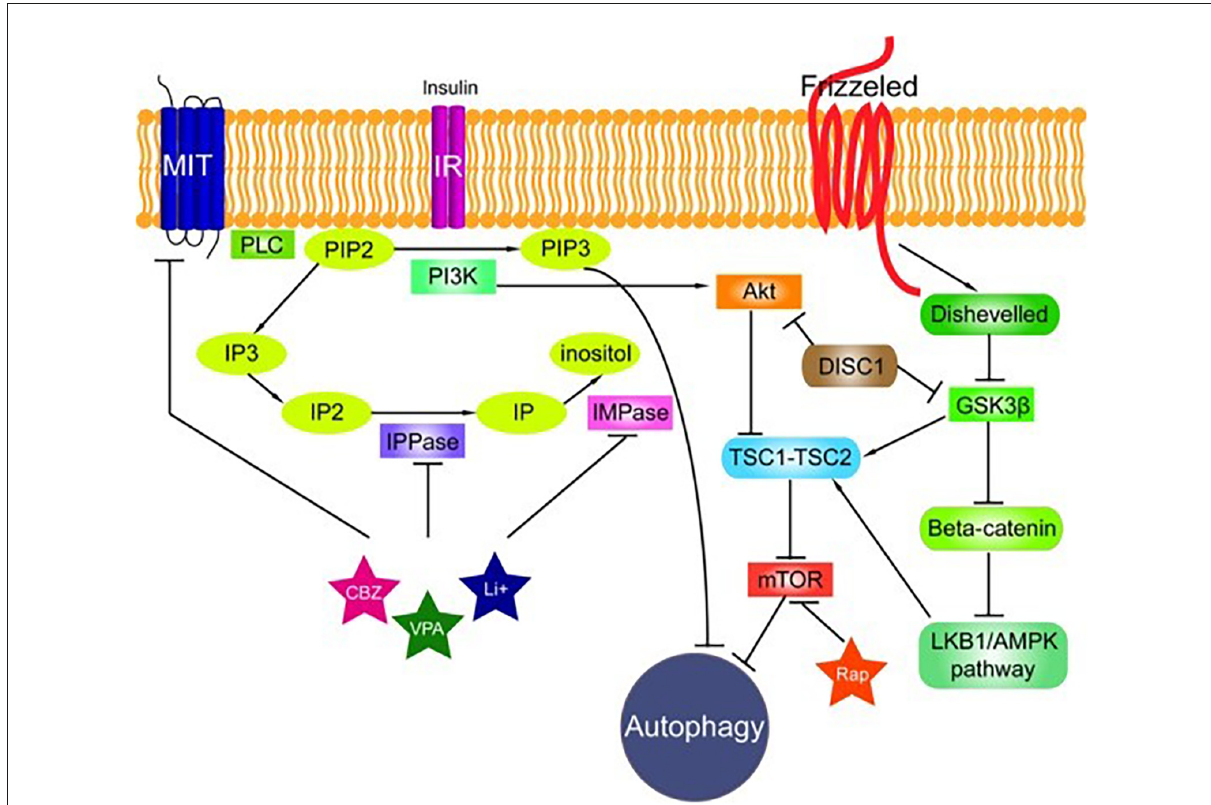
FIGURE4 The signaling pathways connected to autophagy. The phosphatidylinositol signaling pathway is regulated by Class I phosphoinositide 3-kinases (PI3Ks),andPI3KsarelinkedtoanextraordinarilydiversegroupofcellularfunctionsthroughregulationoftheAkt/TSC1-TSC2/mTORpathway.The Disrupted in Schizophrenia 1 (DISC1) gene negatively regulates both glycogen synthase kinase-3 beta (GSK3 β ) and Akt. Wnt signaling activation is mediated through the binding of a Wnt-protein ligand to a frizzled family receptor, which passes the biological signal to disheveled (Dsh). Dsh negatively regulates GSK3 β , which alternatively inhibits β -catenin, one of the central proteins of the Wnt signaling pathway. Reproduced from Polajnar and Žerovnik (2014).